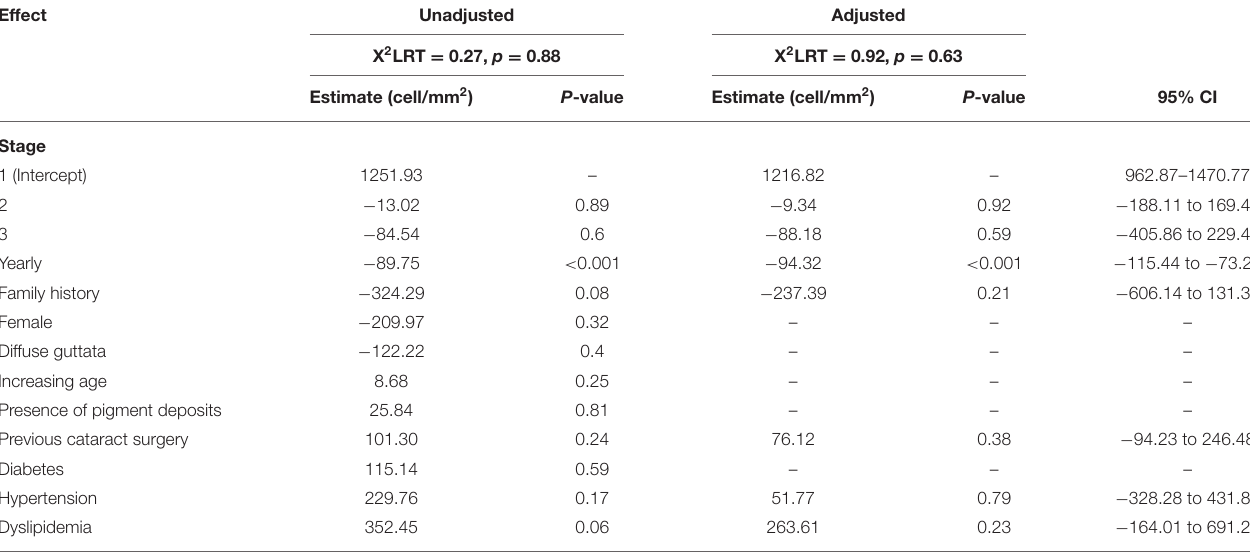
TABLE 2 | Corneal endothelial cell reduction per year and comparison between stages.